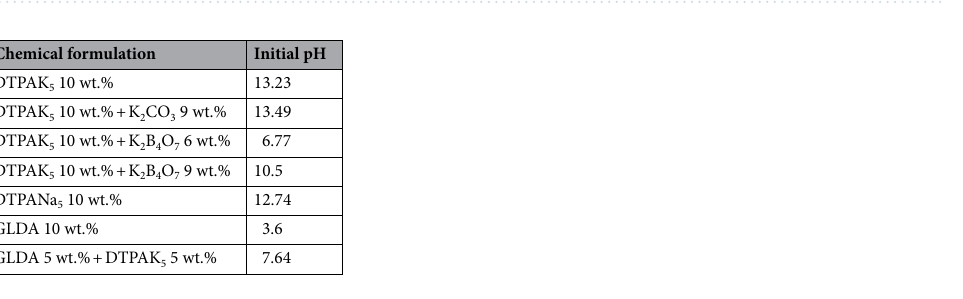
Table 1. Chemical formulations used in the anodic dissolution